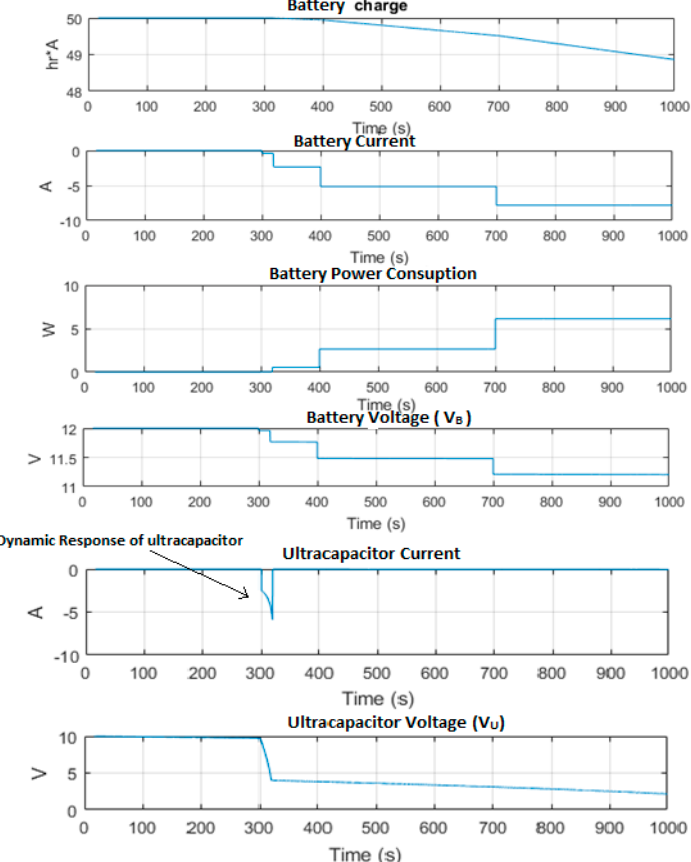
Figure 13. Battery charge, current, power and ultra-capacitor current, voltage characteristics.